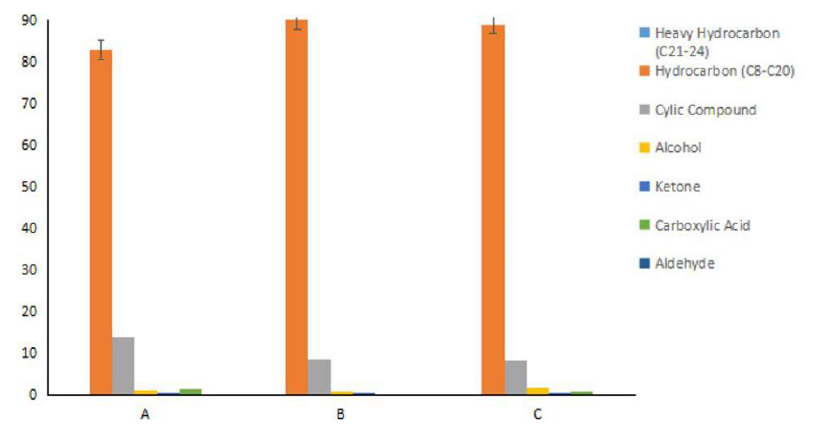
Figure 8. Distribution (%) of DO liquid products from samples A, B and C catalysed by Ni-Mo/AC.